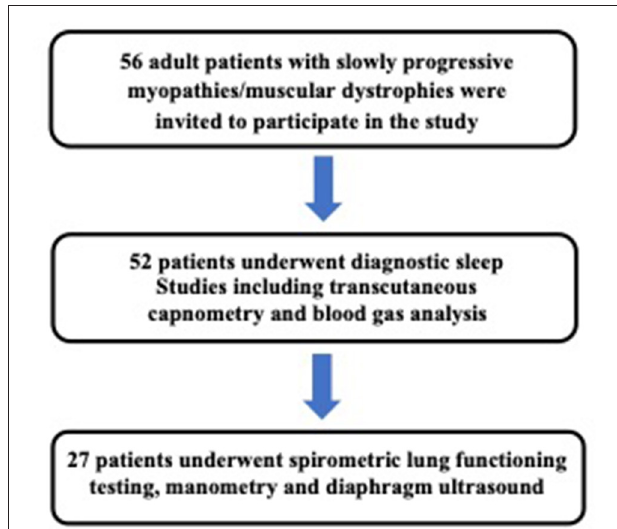
The table depicts Spearman’s correlation coefficients and p-values (in brackets). Correlation analysis was performed in the entire study cohort (n = 27).